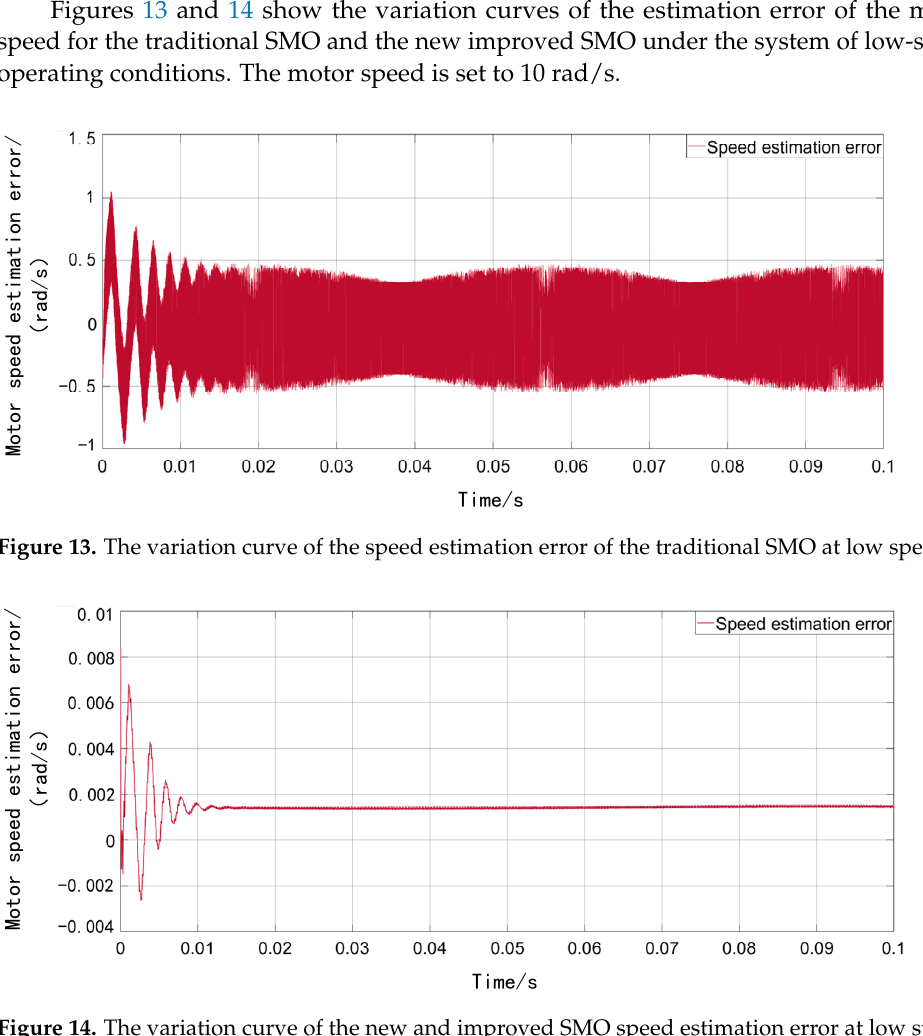
Figure 12. Comparison chart of the motor rotor position of the new and improved SMO at low speed.